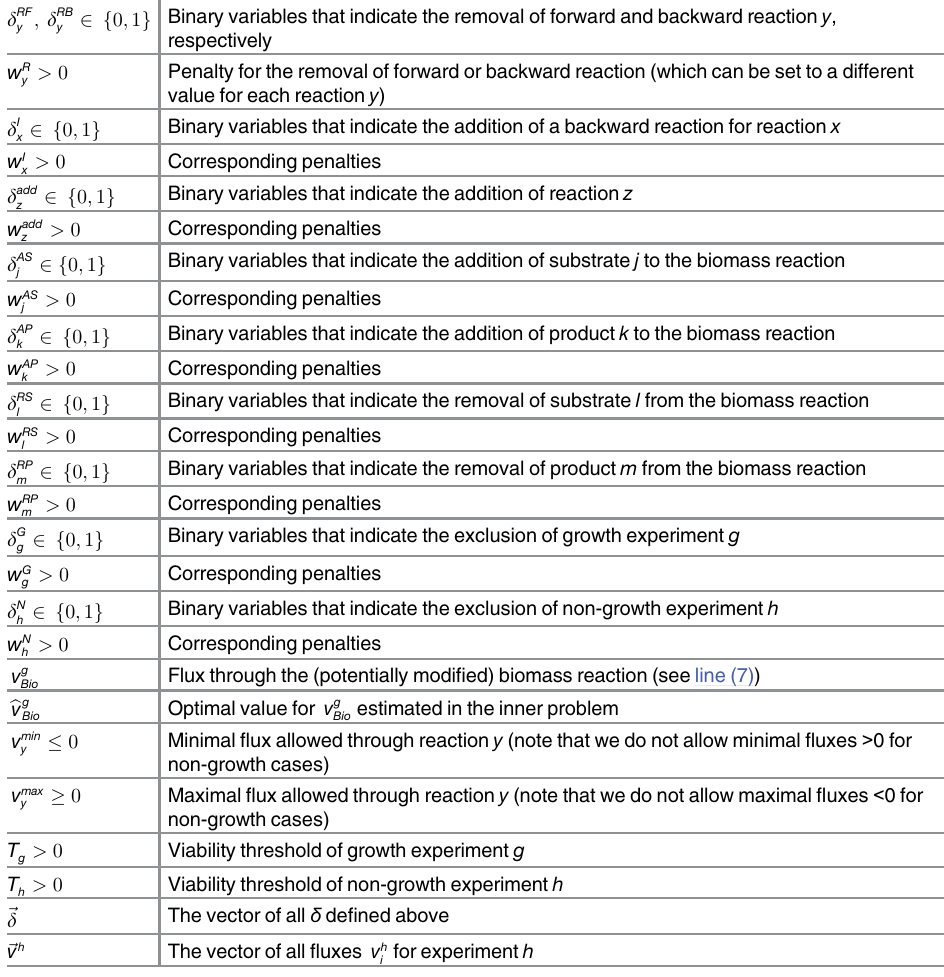
Table 10. The parameters of the system of equations describing the GlobalFit algorithm. d RF ; d RB 2 f 0 ; 1 g Binary variables that indicate the removal of forward and backward reaction y , y y respectively > 0 Penalty for the removal of forward or backward reaction (which can be set to a different w R y value for each reaction y